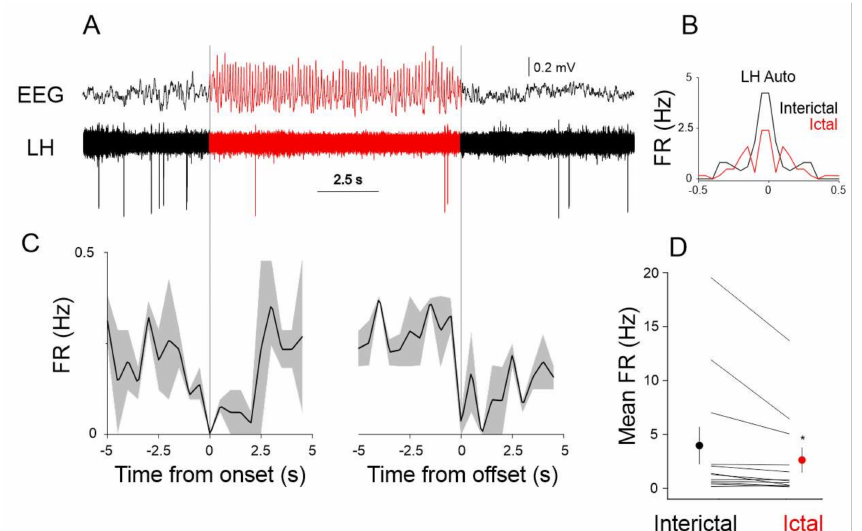
Figure 4. Ictal and interictal neuronal activity in the LH. ( A ) Example single unit recording in the LH during ictal (red) and interictal (black) periods. ( B ) Ictal (red) and interictal (black) autocorrelation of the neuron shown in ( A ), FR: firing rate. ( C ) Peri-event histograms of the firing rate of the neuron shown in ( A ) triggered by the onset (left) and offset of SWDs (see dotted gray lines). Solid lines represent the mean, gray shaded area: s.e.m. ( D ) Mean ictal and interictal firing rates of all the recorded LH neurons (n = 12). Each line represents a neuron, population mean shown as red (ictal) and black (interictal) circles. The asterisk denotes statistical